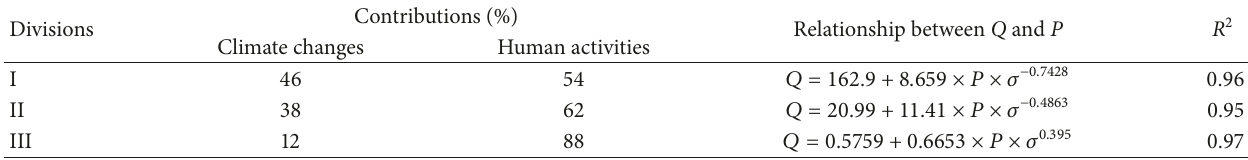
Table 1: Contributions of climate change and human activities to runoff by rainfall-runoff relationship method.